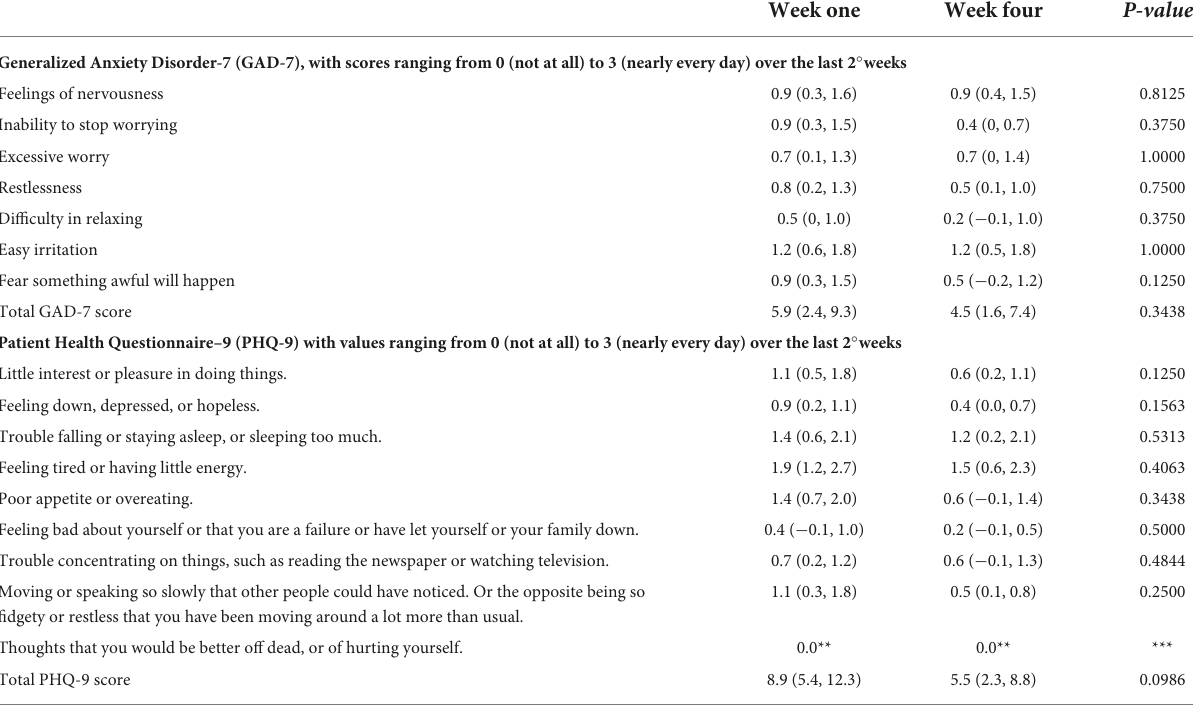
TABLE 4 Social work